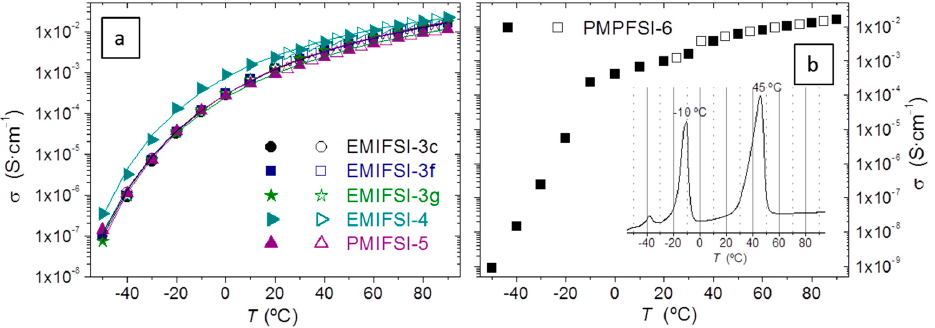
Figure 4. ( a ) σ dependence on temperature during the heating and cooling cycles. The lines are the VFT fitting in Table 4. ( b ) Comparison between σ and DSC curve for PMPFSI-6 electrolyte. The inset shows the DSC trace for this electrolyte.